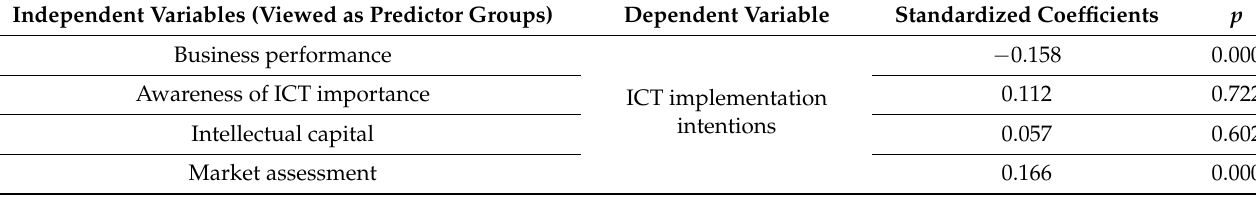
Table 3. Results of the linear regression